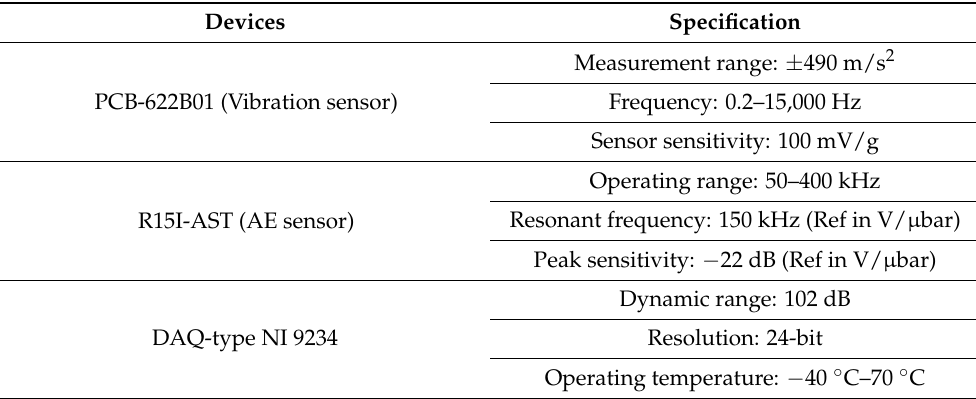
Table 1. Specifications of the data acquisition system.